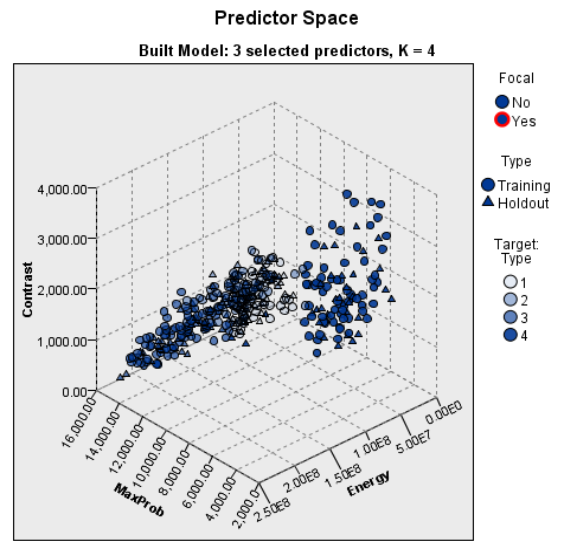
Figure 4. Predictor Space of three selected predictors* *This chart is a lower-dimensional projection of the predictor space, which contains a total of 5 predictors.